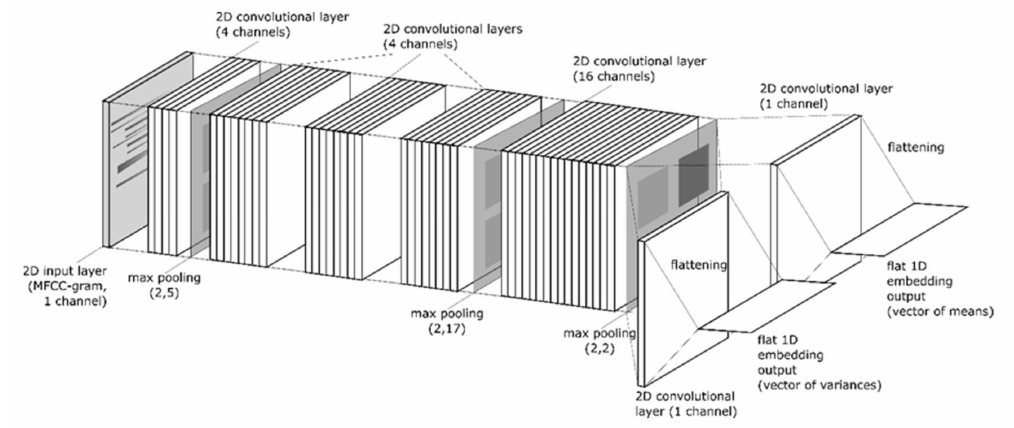
Figure 8. Structure of the encoding part of the variational autoencoder used in the